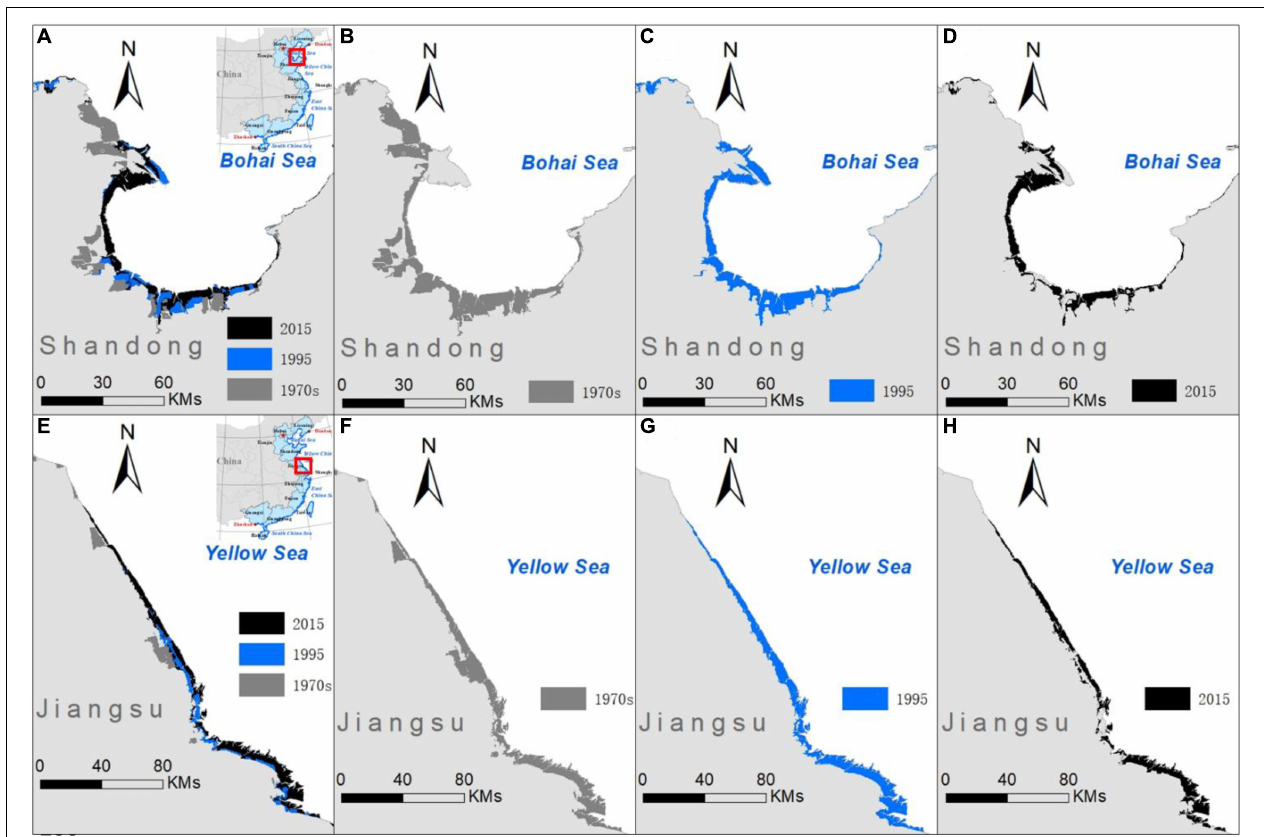
FIGURE 7 | Reduction in the inter-tidal width of the Bohai Rim (A–D) and Yellow sea coast (E–H)